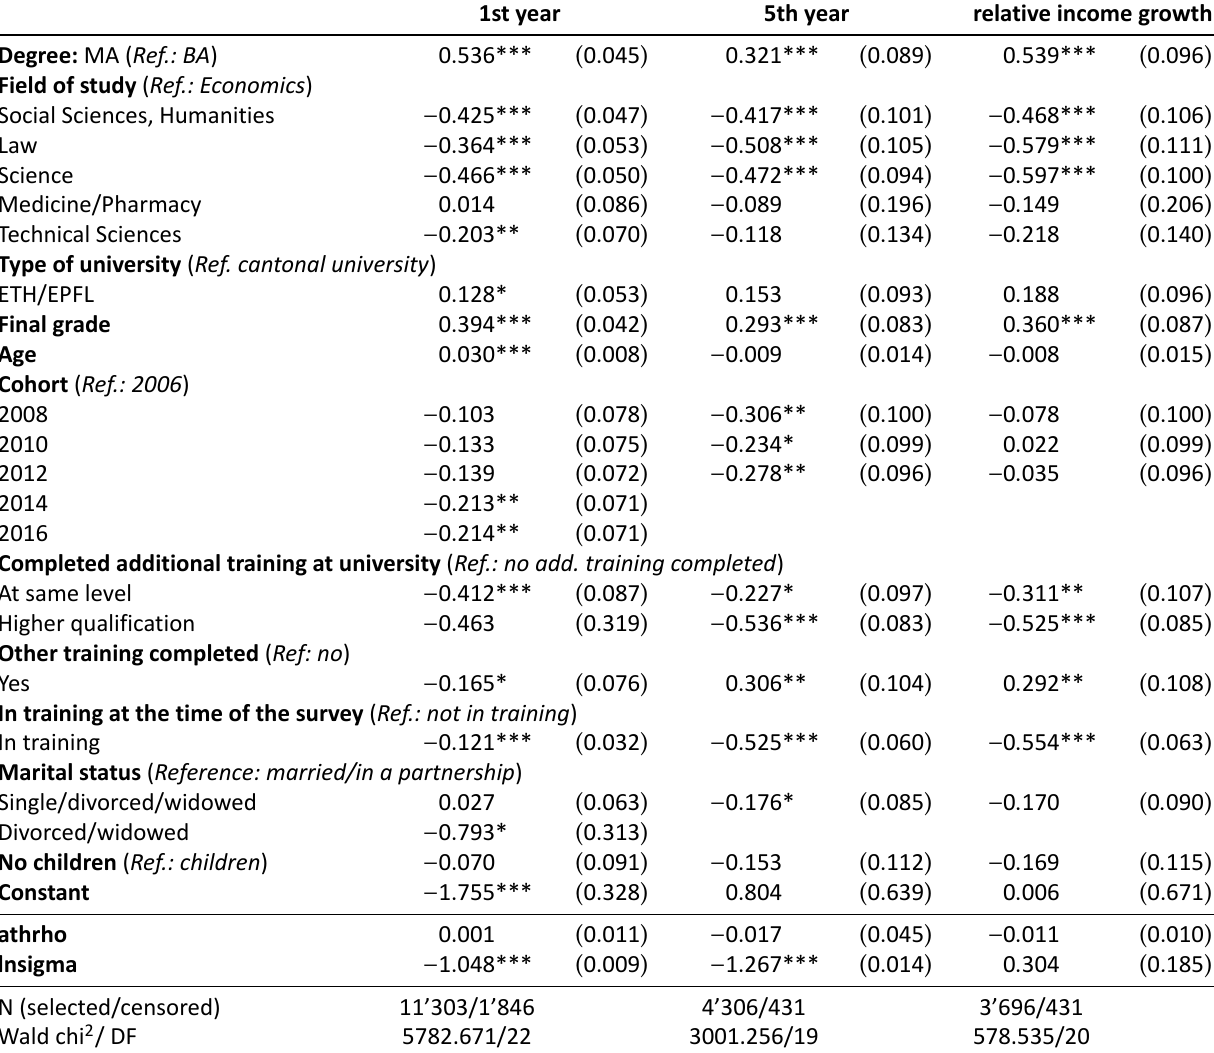
Table A3. Men’s monthly income (log.) in the first and fifth year after graduation and relative income growth, results of selection equations for Table